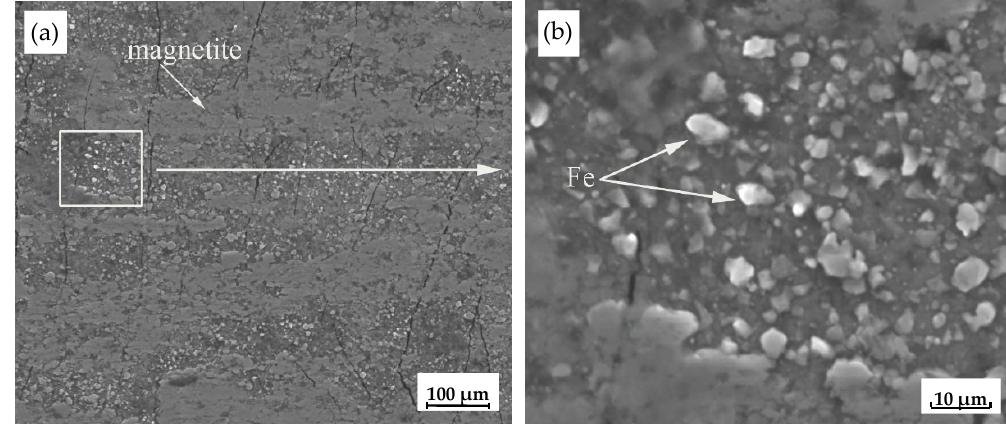
Figure 12. SEM images of type I oxide scale sample: ( a ) surface morphology of type I oxide scale; ( b ) Fe particles on the type I oxide scale.